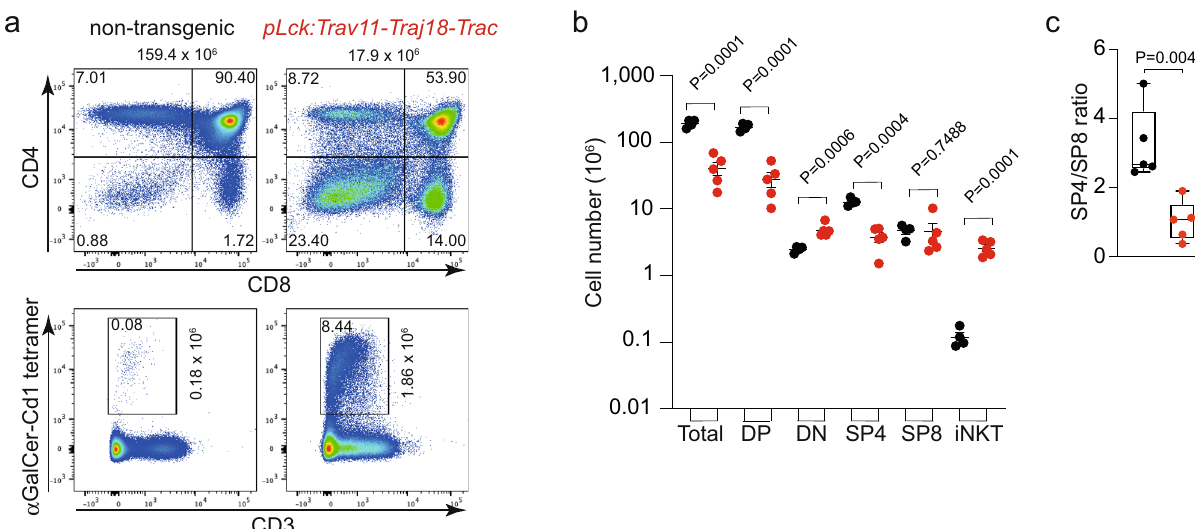
Fig. 4 Altered thymocyte differentiation in pLck:Trav11-Traj18-Trac transgenic mice. a Representative fl ow cytometric pro fi les of non-transgenic wild- type and transgenic thymocytes of 4-week-old mice. The total numbers of thymocytes are indicated at the top of the upper panels; the proportions of individual thymocyte populations are indicated in the respective quadrants. In transgenic mice, the absolute number of iNKT cells (CD3 + α GalCer-CD1 tetramer + ; boxed with indicated proportions) is increased; absolute numbers are given next to the quadrant marking iNKT cells. b Numbers of thymocyte populations in non-transgenic wild-type (black; n = 4) and transgenic (red; n = 5) mice (mean ± s.e.m.; t-test, two-tailed; P values are indicated). c Reduced SP4/SP8 ratios in transgenic mice (red). The difference between the populations is signi fi cant (t-test, two-tailed; n = 5 for both genotypes; P value is indicated). Box plots show quantiles 25 and 75 and mean (line) as well as the total range